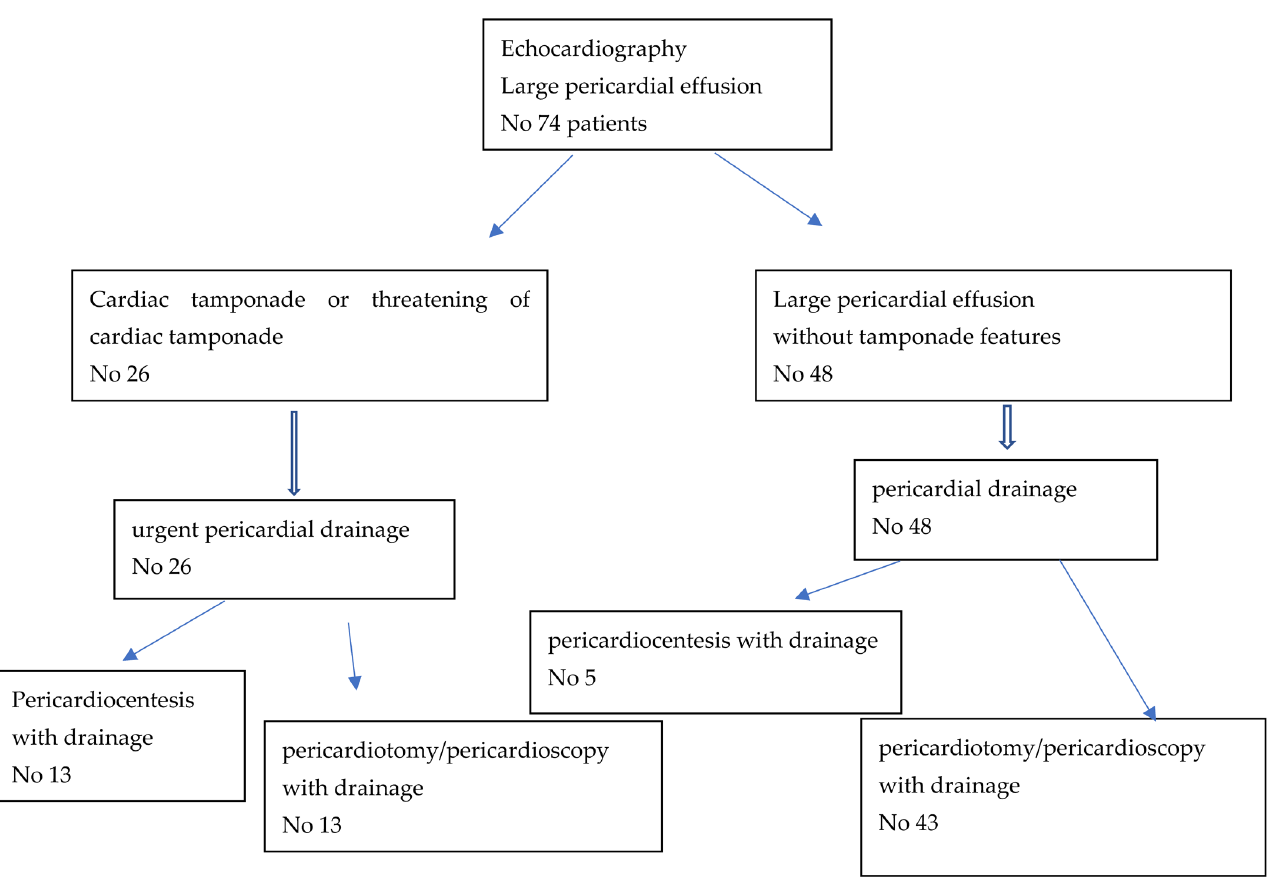
Table 1. Etiology, hemodynamic consequences, and applied treatment modalities in 74 with large pericardial effusion.